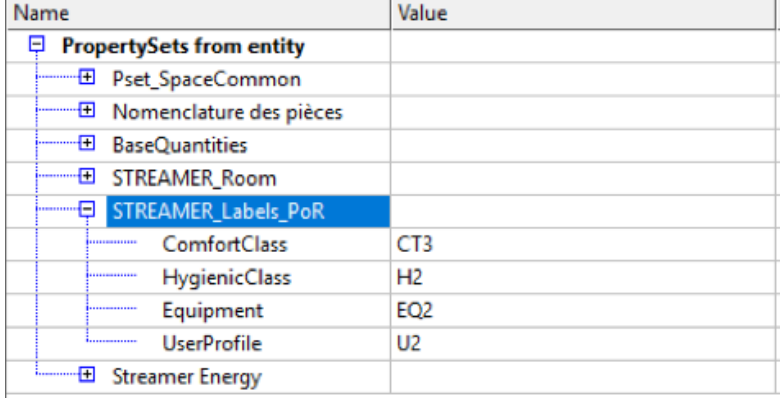
Figure 7. Labels assigned to a given space in TECT and integrated in the IFC